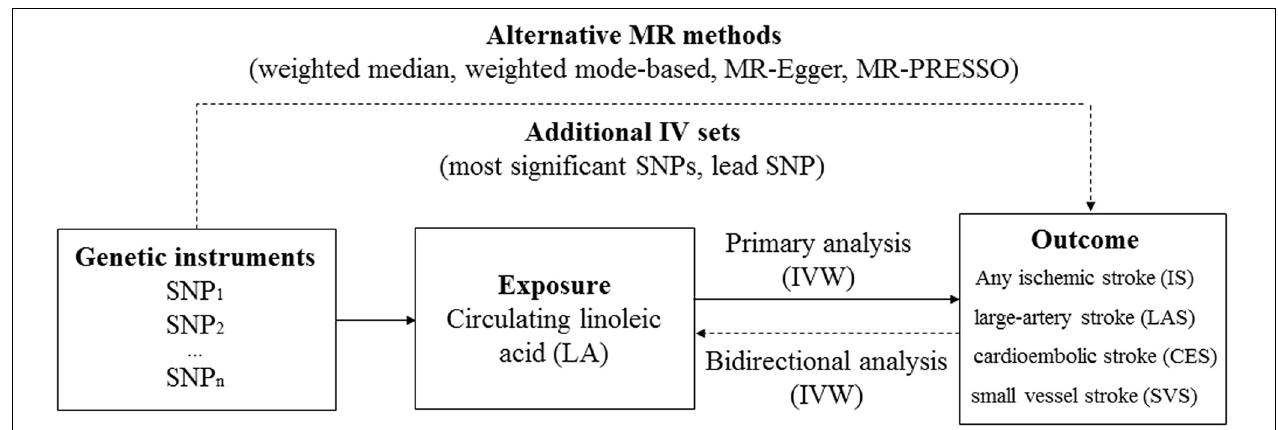
FIGURE 1 | An overview of the Mendelian randomization (MR) study design. Abbreviation: IVW, inverse-variance weighted; PRESSO, Pleiotropy RESidual Sum and Outlier.